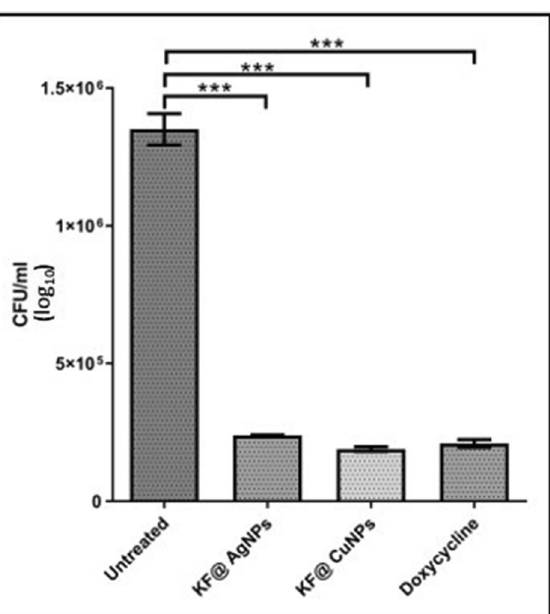
Figure 7. Infection study on Zebra fish model. Colony counts after treatment with KF@AgNPs, KF@CuNPS and Doxycycline. *** p <